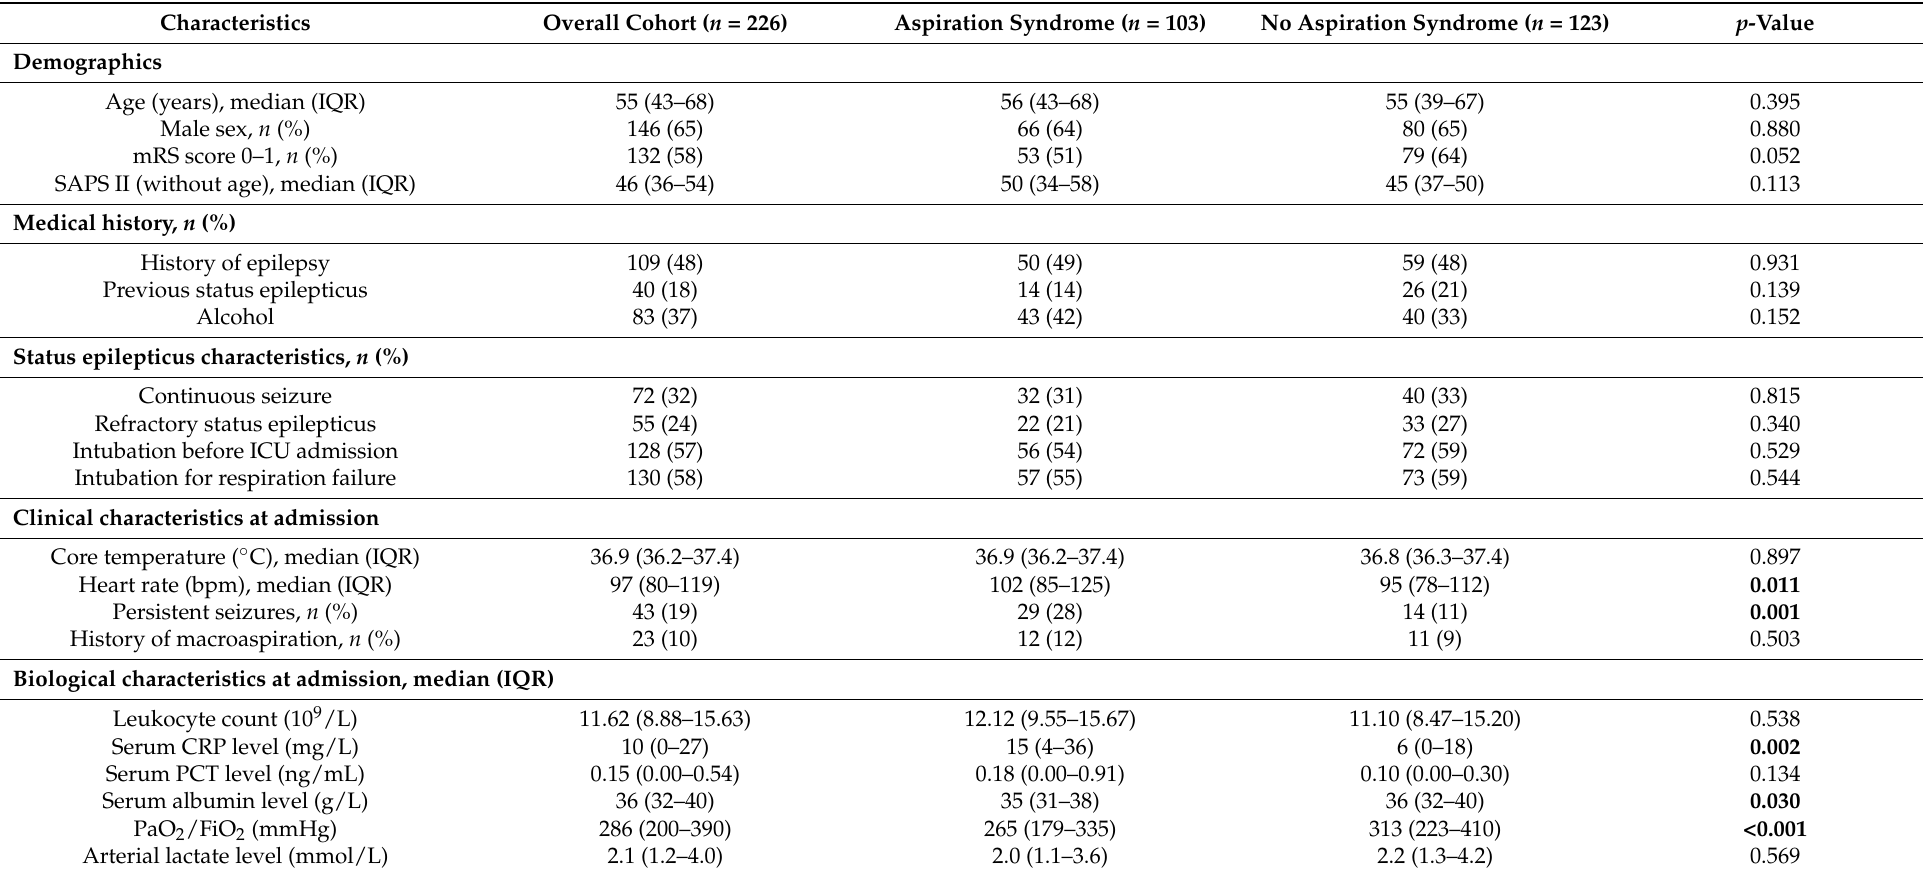
Table 1. Characteristics and outcomes of patients with and without aspiration